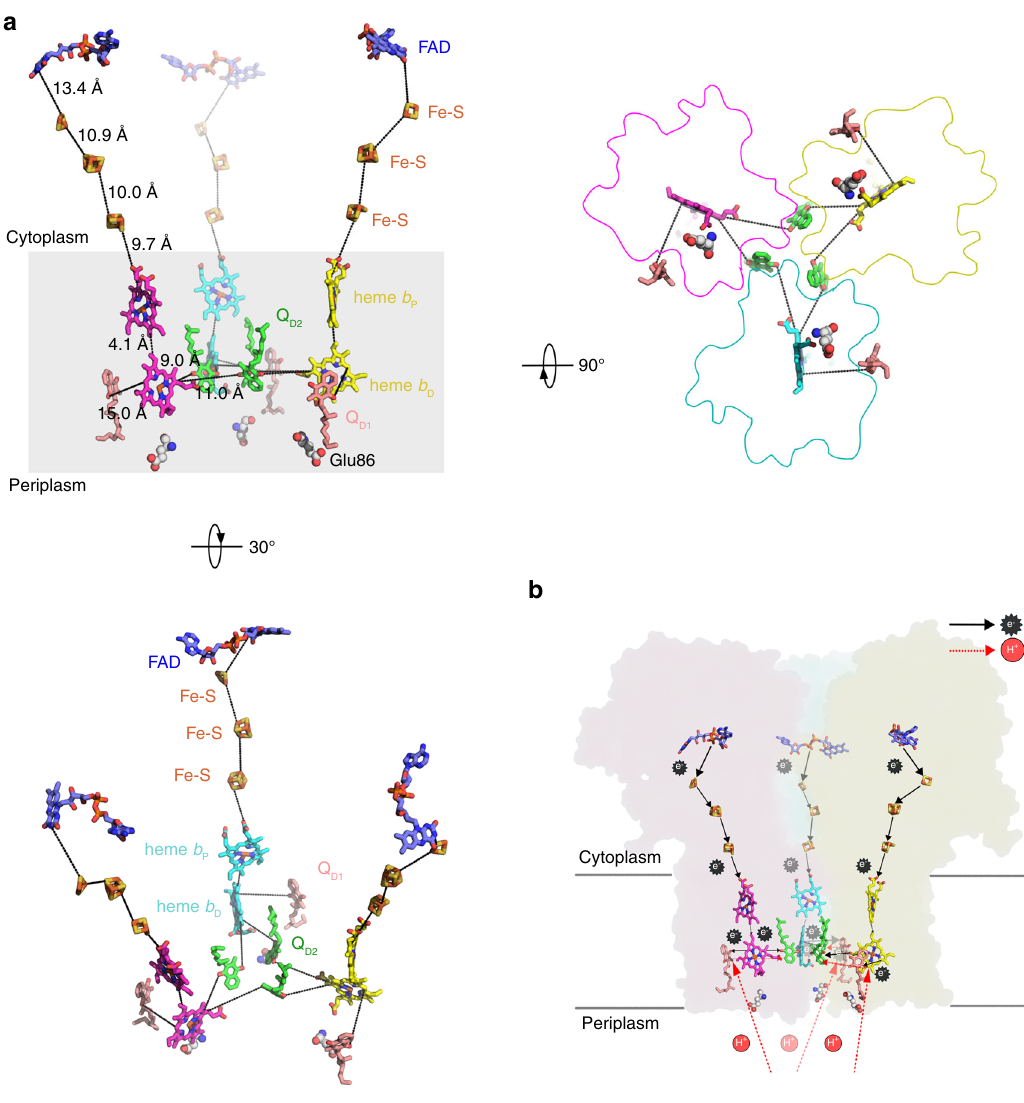
Fig. 4 Electron/proton transfer pathway in the Sdh2 trimer. a The prosthetic groups, FAD, Fe-S clusters, hemes, and MK, are shown in stick or sphere. The edge-to-edge distances between adjacent prosthetic groups are labeled in black dashed lines. b Representation of electron and proton transfer way between adjacent protomers in the trimer. Electron transfer directions are shown in black arrows. Proton transfer pathways are shown by the red